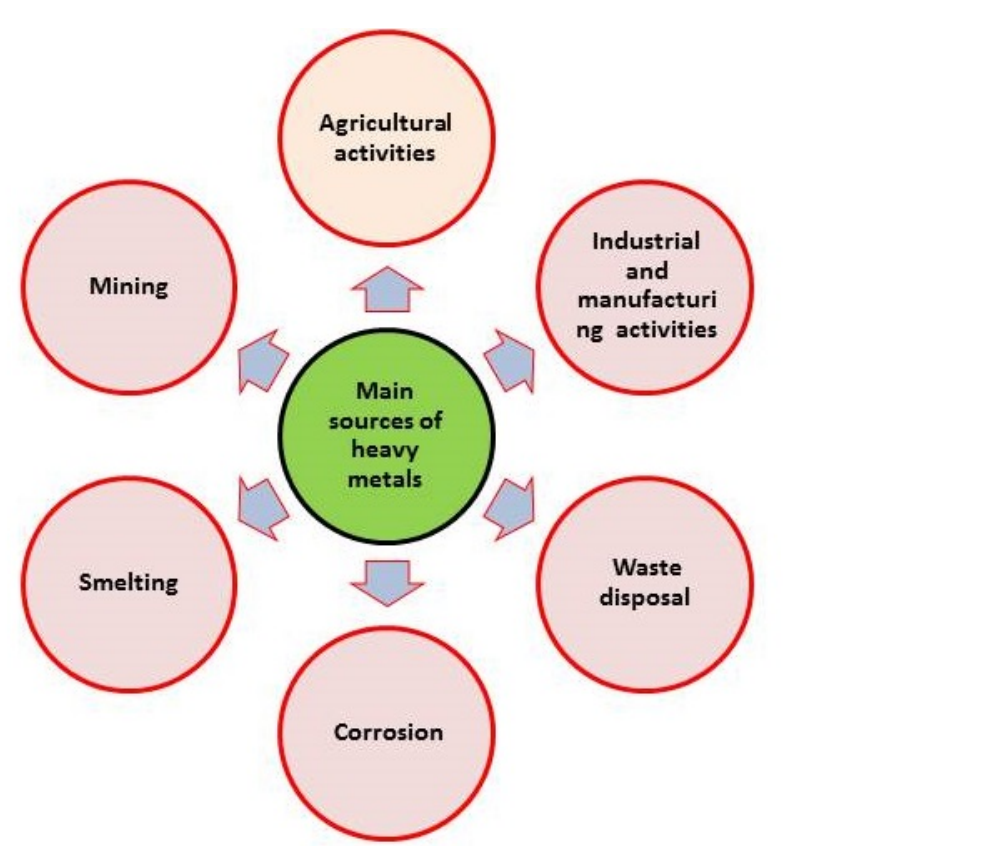
Figure 1. Main sources of heavy metals in the